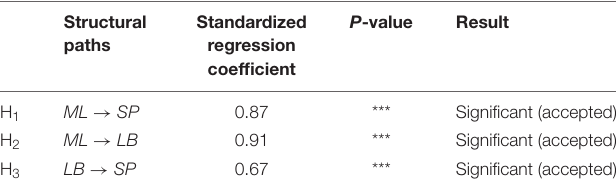
TABLE 6 | Standardized regression weights (direct